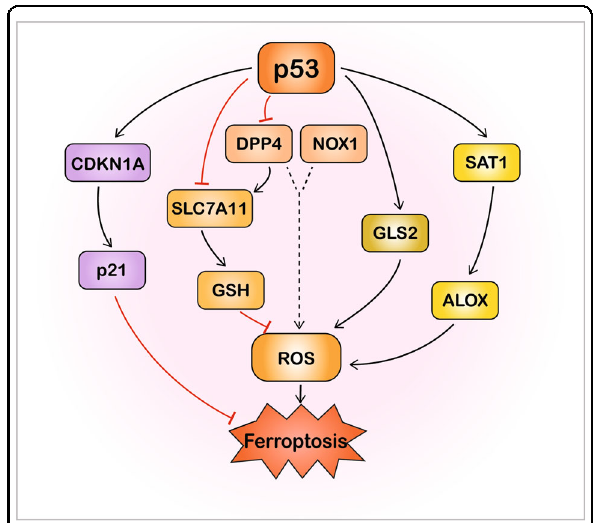
Fig. 3 p53-mediated ferroptosis. p53 plays a dual role in the regulation of ferroptosis through transcriptional or posttranslational mechanisms in different contexts. On one hand, p53 induces ferroptosis through inhibition of SLC7A11 or upregulation of GSL2 and SAT1 – ALOX pathway. On the other hand, p53 also inhibits ferroptosis through inhibition of DPP4 activity or by the transcriptional activation of CDKN1A/p21. ALOX arachidonate lipoxygenase, CDKN1A